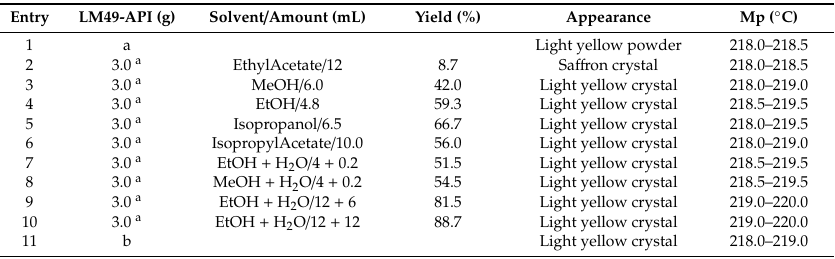
Table 13. Polymorph investigation of LM49-API in di ff erent solvents.